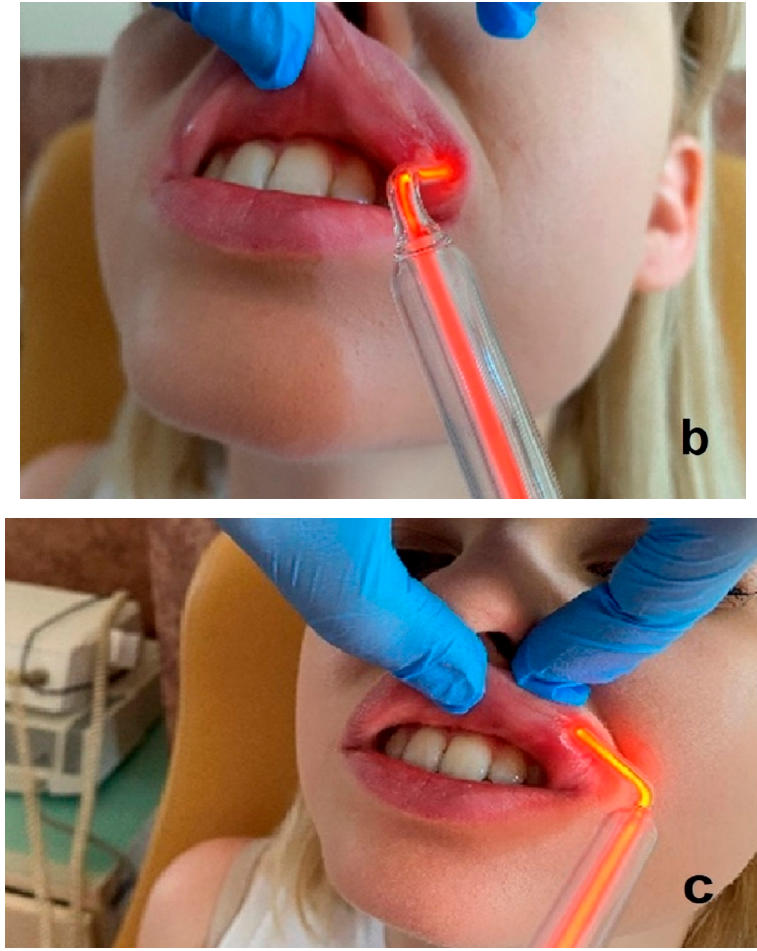
Figure 5. Example of herpes simplex virus on the upper lip mucosa ( a ) before treatment, ( b ) during therapy, ( c ) after three days of ozone therapy. The glass probe of the OzonyTron ozone generator (Mymed) was used (authors’ own photographic documentation).